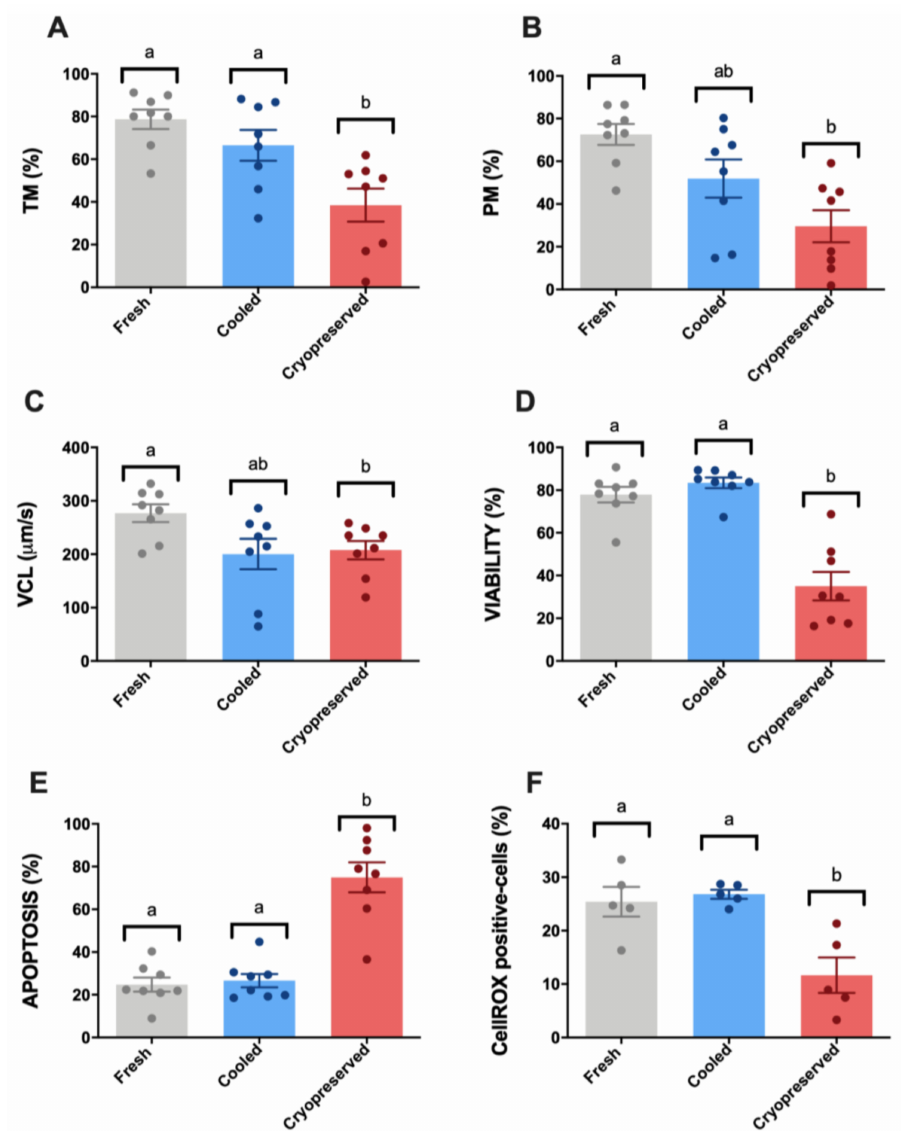
Figure 1. Ram sperm motility and multiparametric flow cytometry analyses in the three experimental groups (fresh, cooled, and cryopreserved samples). ( A ) Total motility (TM, %); ( B ) progressive motility (PM, %); ( C ) curvilinear velocity (VCL, µ m / s); ( D ) Zombie negative cells (viability, %); ( E ) caspase 3 / 7 positive cells (apoptosis, %); ( F ) CellROX-positive cells (sperm ROS levels, %). The same five-eight males were analyzed in each experimental group. Graph dots represent individual male ejaculates. Significant di ff erences ( p < 0.05) are represented with di ff erent